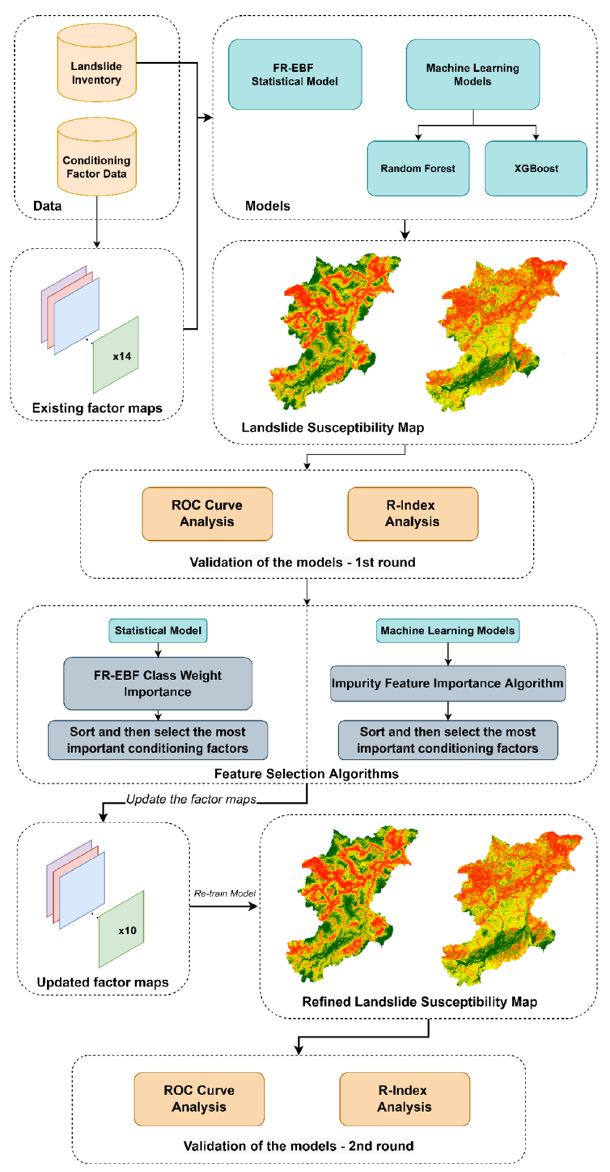
Figure 3. Overview of the conceptual workflow of the methodology for landslide susceptibility